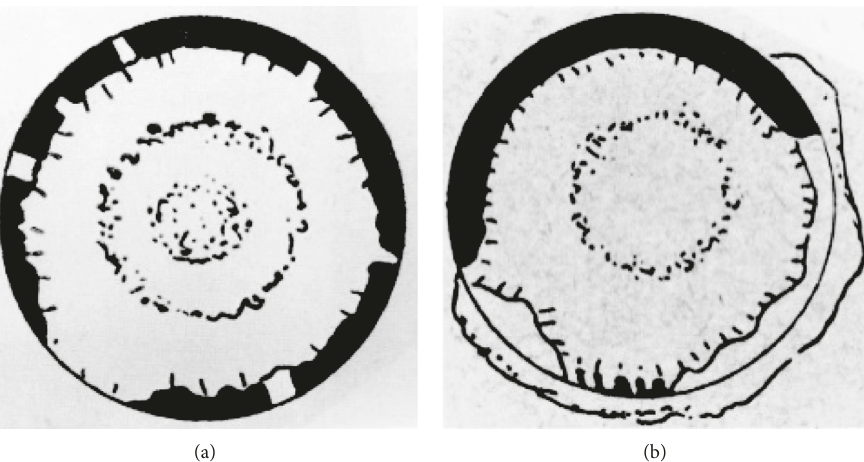
Figure 1: Hand drawings of Lindberg: The central disc and peripheral band are illustrated as well as the degeneration of the pupillary border.